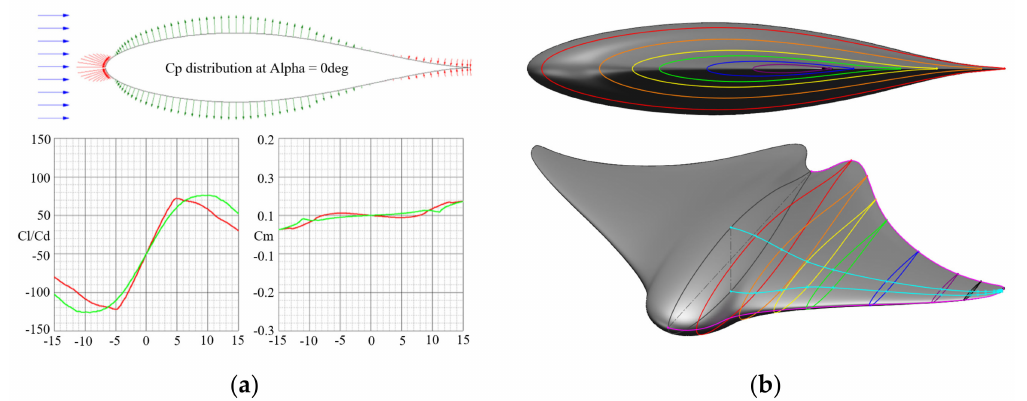
Figure 2. Parametric geometry of the cownose ray. ( a ) 2D profile calculation based on NACA airfoil database; ( b ) 3D surface generation using multi − section lofting and spline control.